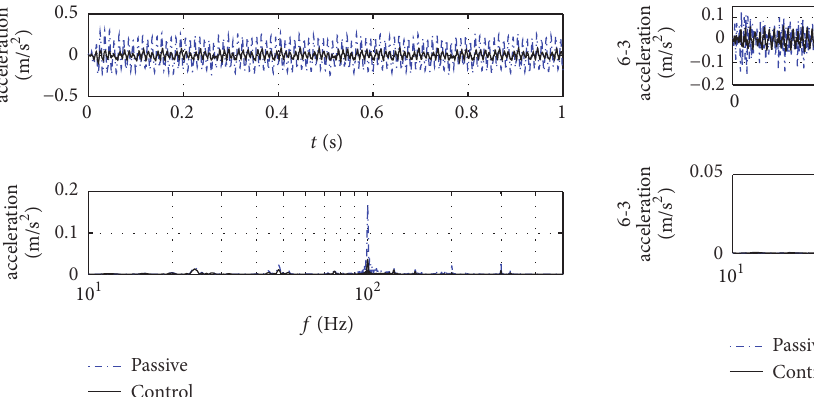
Figure 25: Comparison time-frequency domain curves of acceler- ation response of position 6-3 on the experimental platform before and after being controlled.